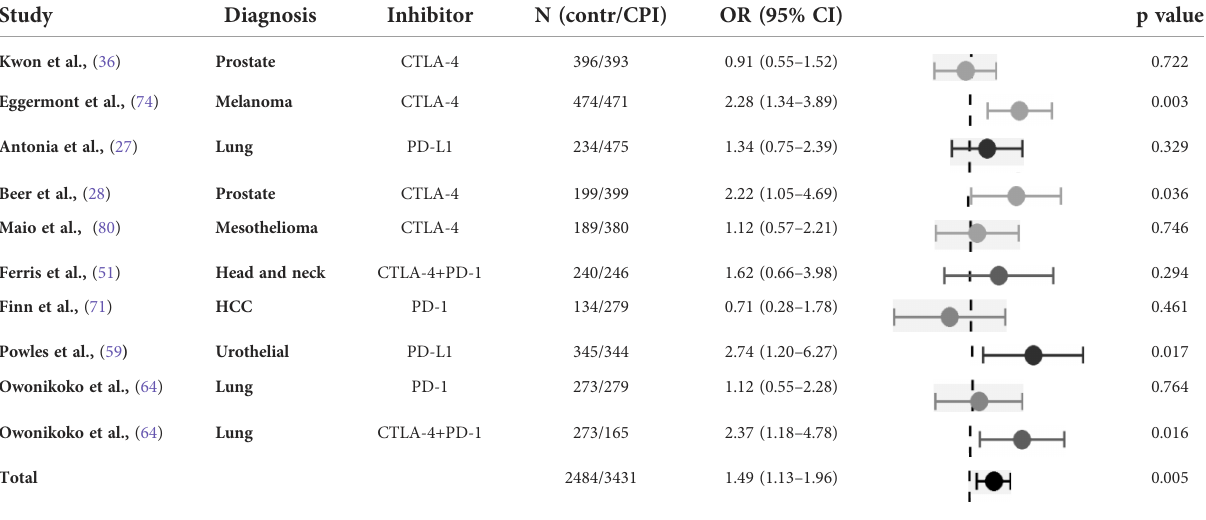
TABLE 5 Odds ratio of insomnia in randomised studies of checkpoint inhibitors versus inactive treatment (placebo and/or best supportive care), with control arm used as reference.